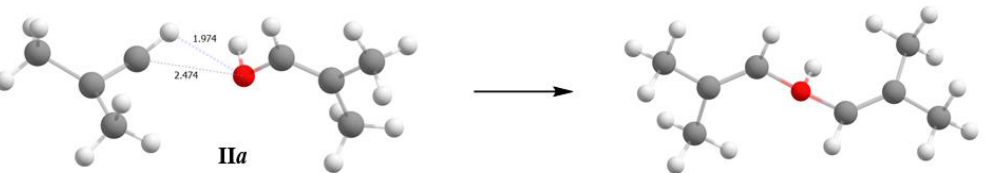
Figure 10. A comparison of two structures: IIa with optimized H atomic coordinates and fixed atomic C and O coordinates equal to those, determined from X-ray crystallography and optimized structure for all atomic coordinates for vacuum (at the UB3LYP/6- 311++G(d,p) level of theory).